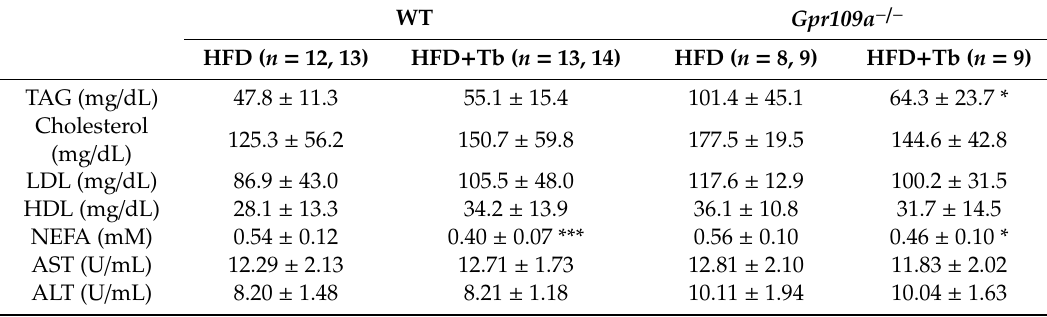
Table 2. Biochemical parameters measured in the serum from 6 h fasted WT and Gpr109a − / − mice treated or not with